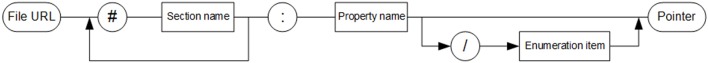
The syntax diagram describing the pointer string construction.